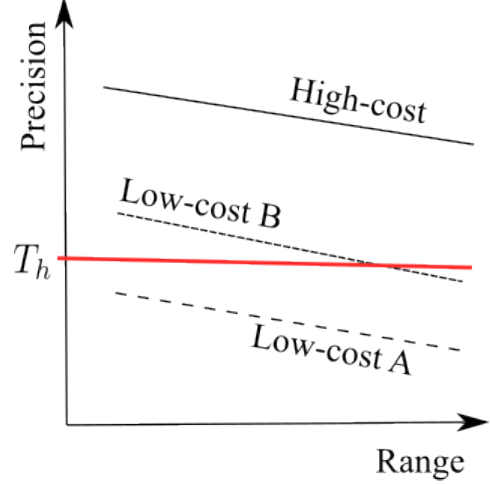
Figure 9: Schematic on the benefits of high-cost sensors. The ’Range’ axis is connected to the sensor resolution, i.e., a high- cost sensor may yield the same resolution from a long range than what a low-cost sensor yields from short range. The feasibil- ity threshold T h can be well examined from above by artificially downgrading the data quality from a high-cost sensor, but not so with case A or case B low-cost